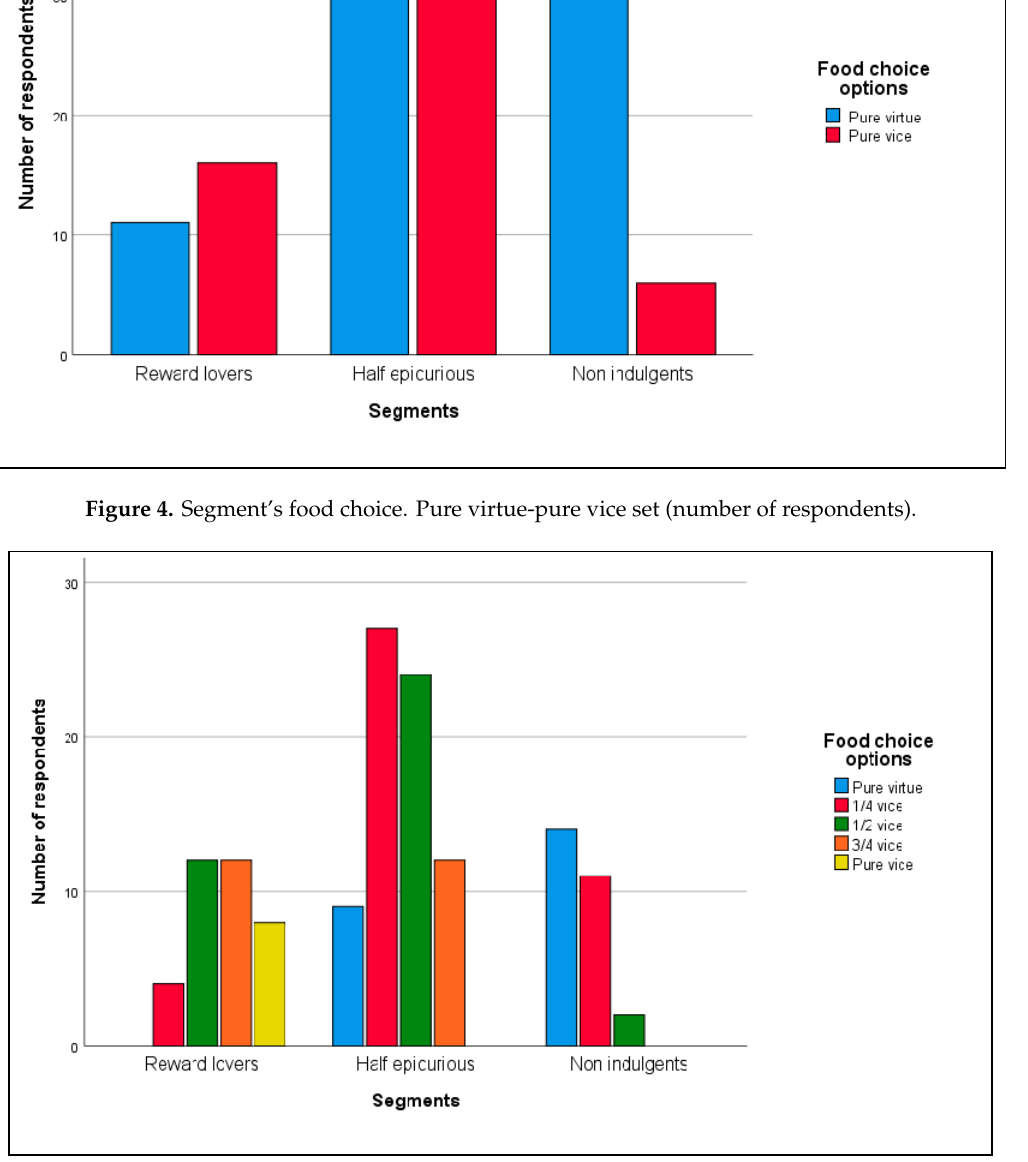
Figure 5. Segments food choice. Five options bundle (number of respondents).